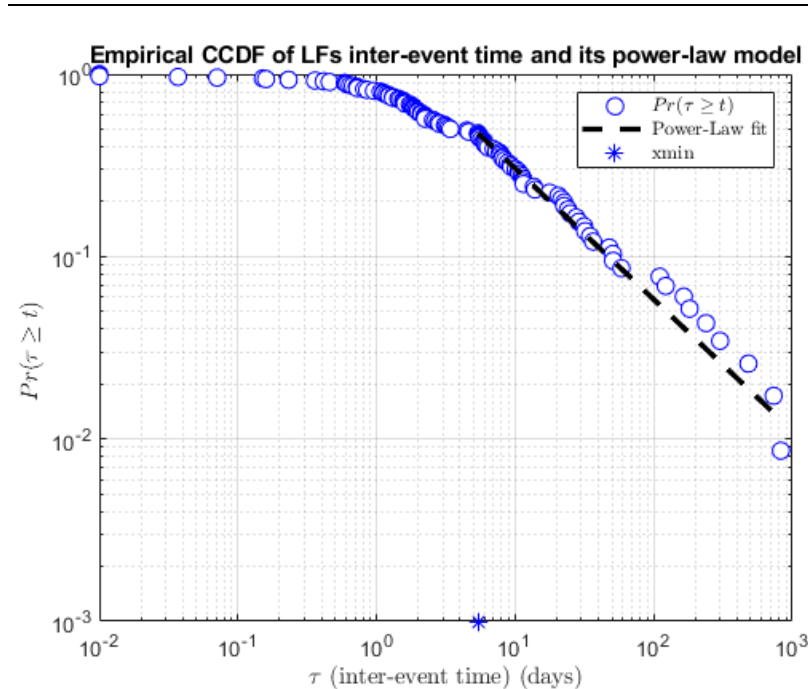
Figure 5. Empirical complementary cumulative distribution function (CCDF) (blue circles) and its power-law model fit (dotted black line) obtained by using the inter-event time of lava fountains (LF) at Etna between January 2011 and July 2022. The symbol ‘*’ in the abscissa indicates the estimated 𝑥 x min for the inter-event time interval τ